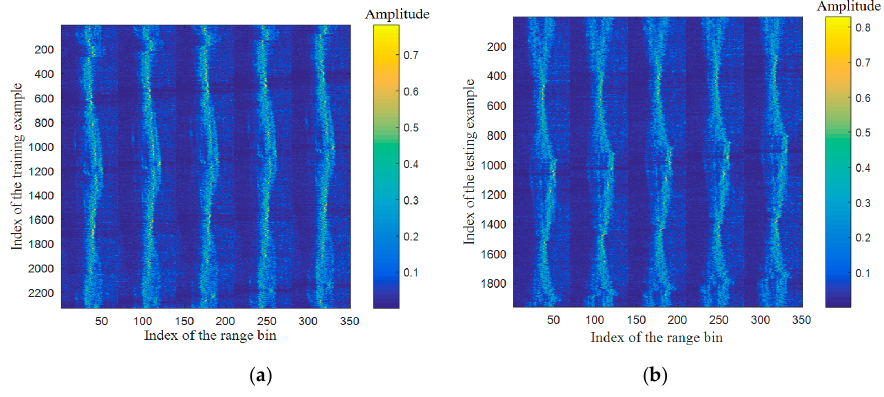
Figure 3. Some examples of training and testing HRRP sequences, ( a ) training; ( b ) testing.